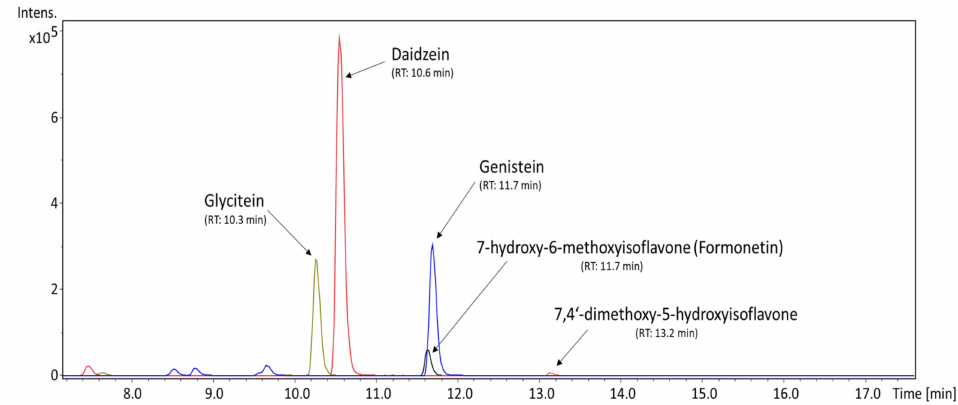
Figure 1. Extracted ion chromatogram of isoflavones from the methanol extract of doenjang, represented as m/z of [M + H] +